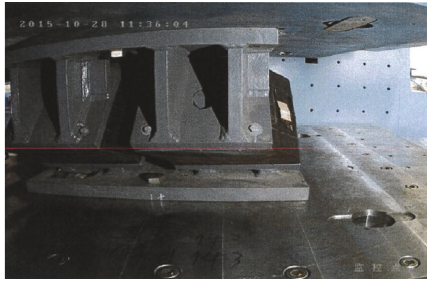
Figure 13: Test picture when shear displacement is +75 mm.